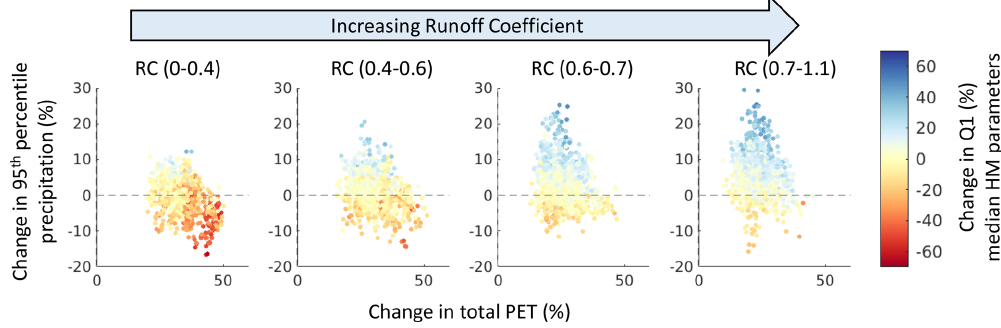
Figure 10. Runoff coefficient (runoff divided by precipitation) vs. flow sensitivity to climatic